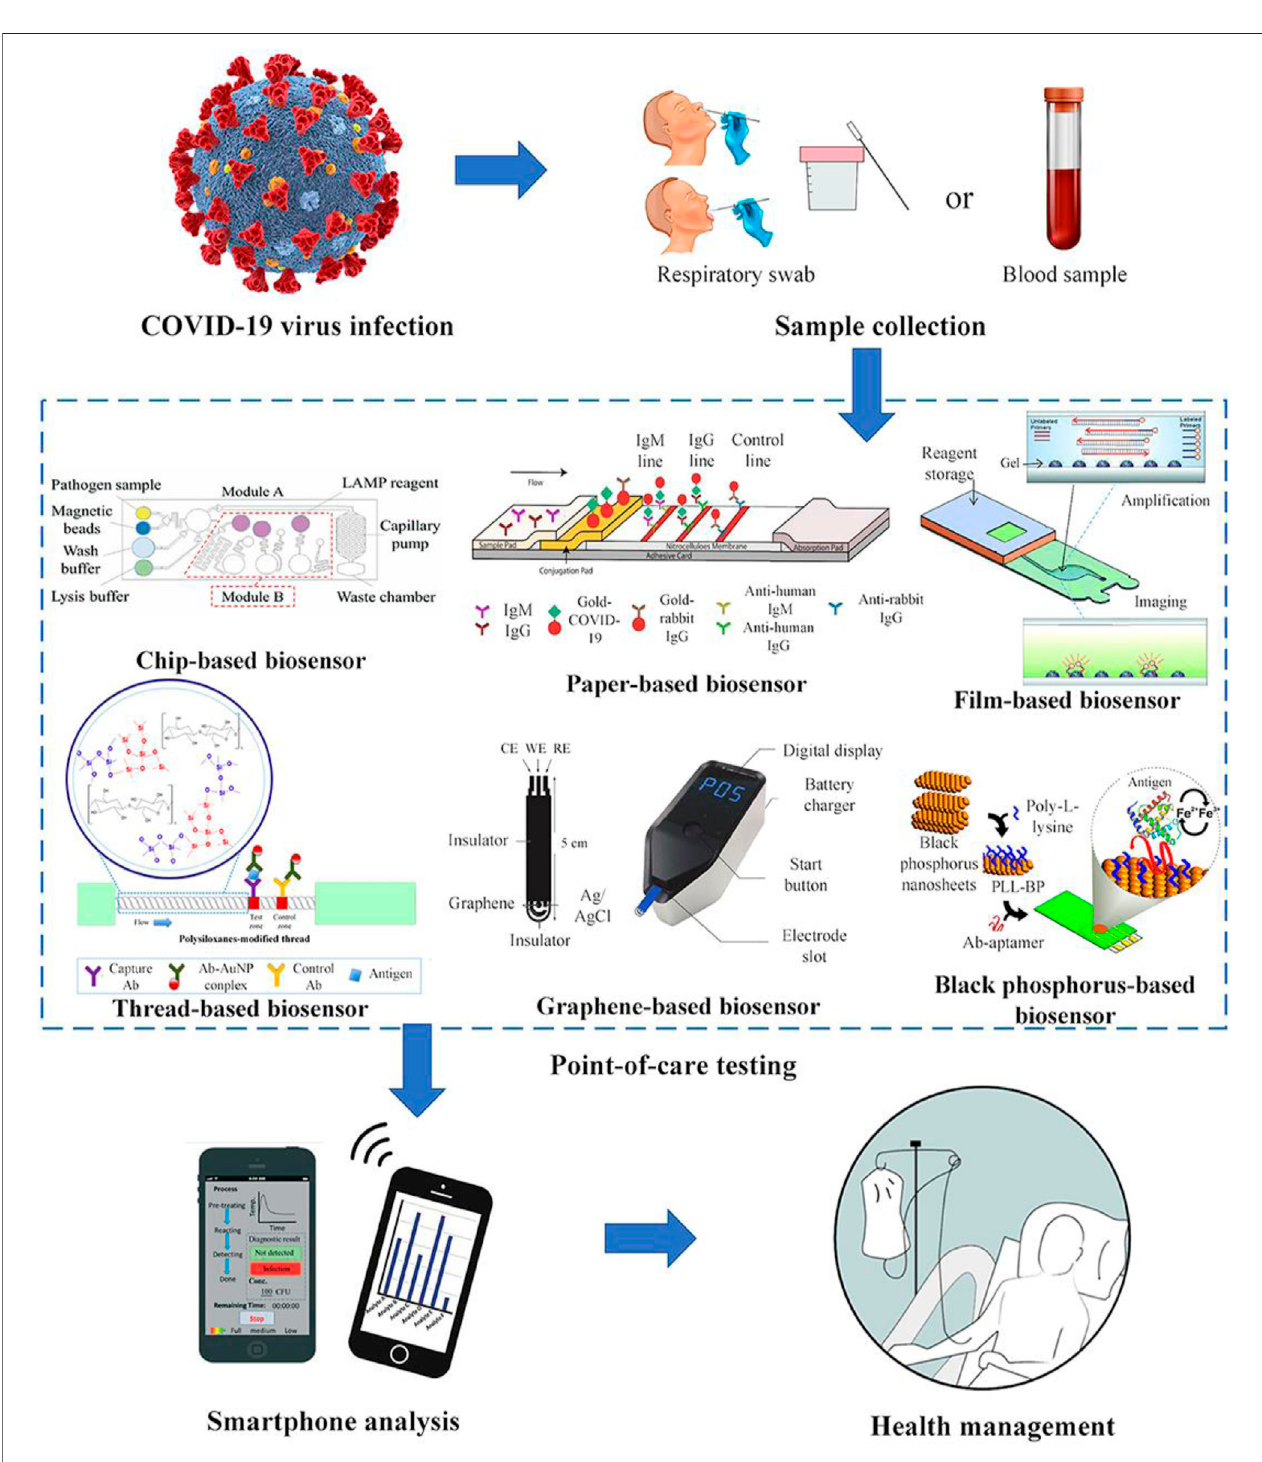
FIGURE 2 | Schematic presentation of the different technologies used for the detection of COVID-19 (reprinted with permission obtained from reference (Choi, 2020).